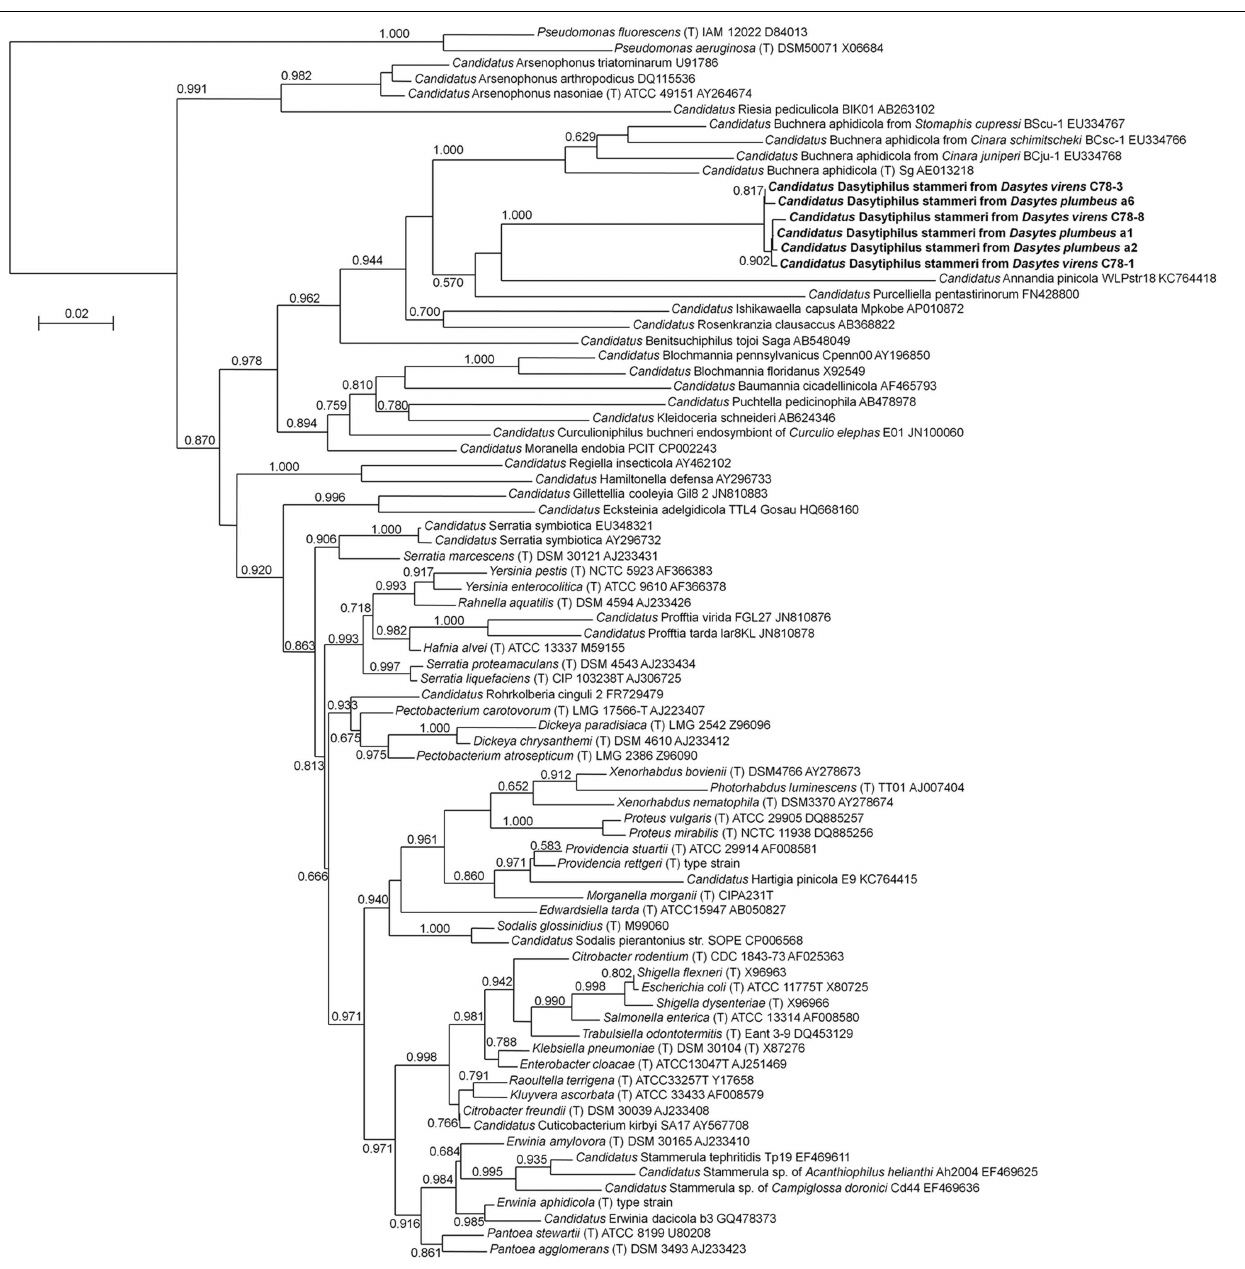
FIGURE 1 | Phylogenetic affiliation of ‘ Candidatus Dasytiphilus stammeri’ within the Enterobacteriaceae. Phylogenetic relationships were reconstructed with an approximately-maximum-likelihood algorithm as implemented in FastTree 2.1.3 (Price et al., 2010) using the GTR model. Local support values from 1,000 resamples are given at the